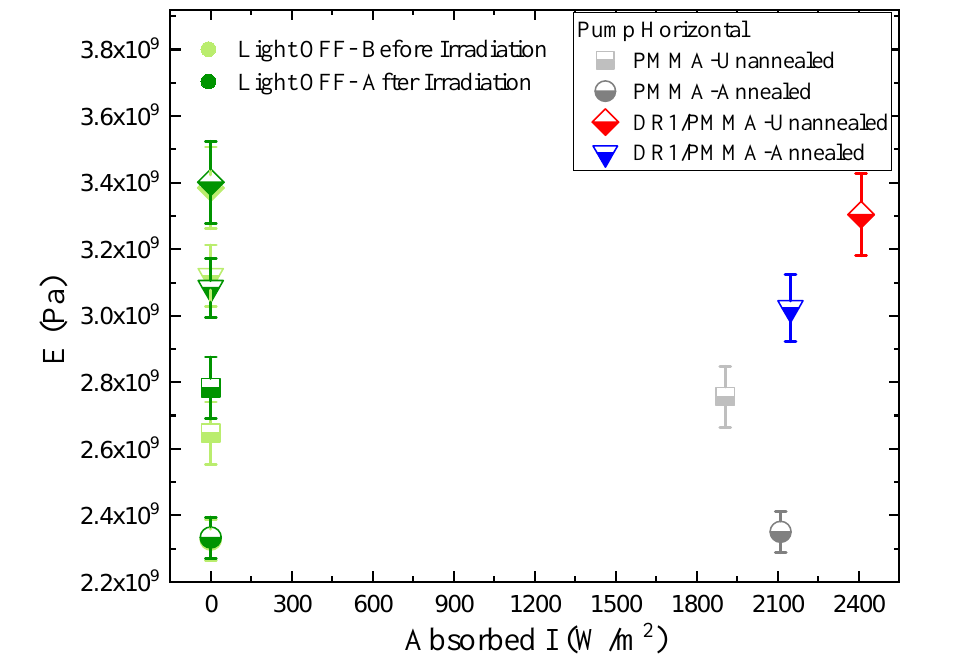
Figure 13. Young’s Modulus for unannealed and annealed PMMA and DR1/PMMA fibers as a function of maximum horizontally polarized absorbed pump intensity.